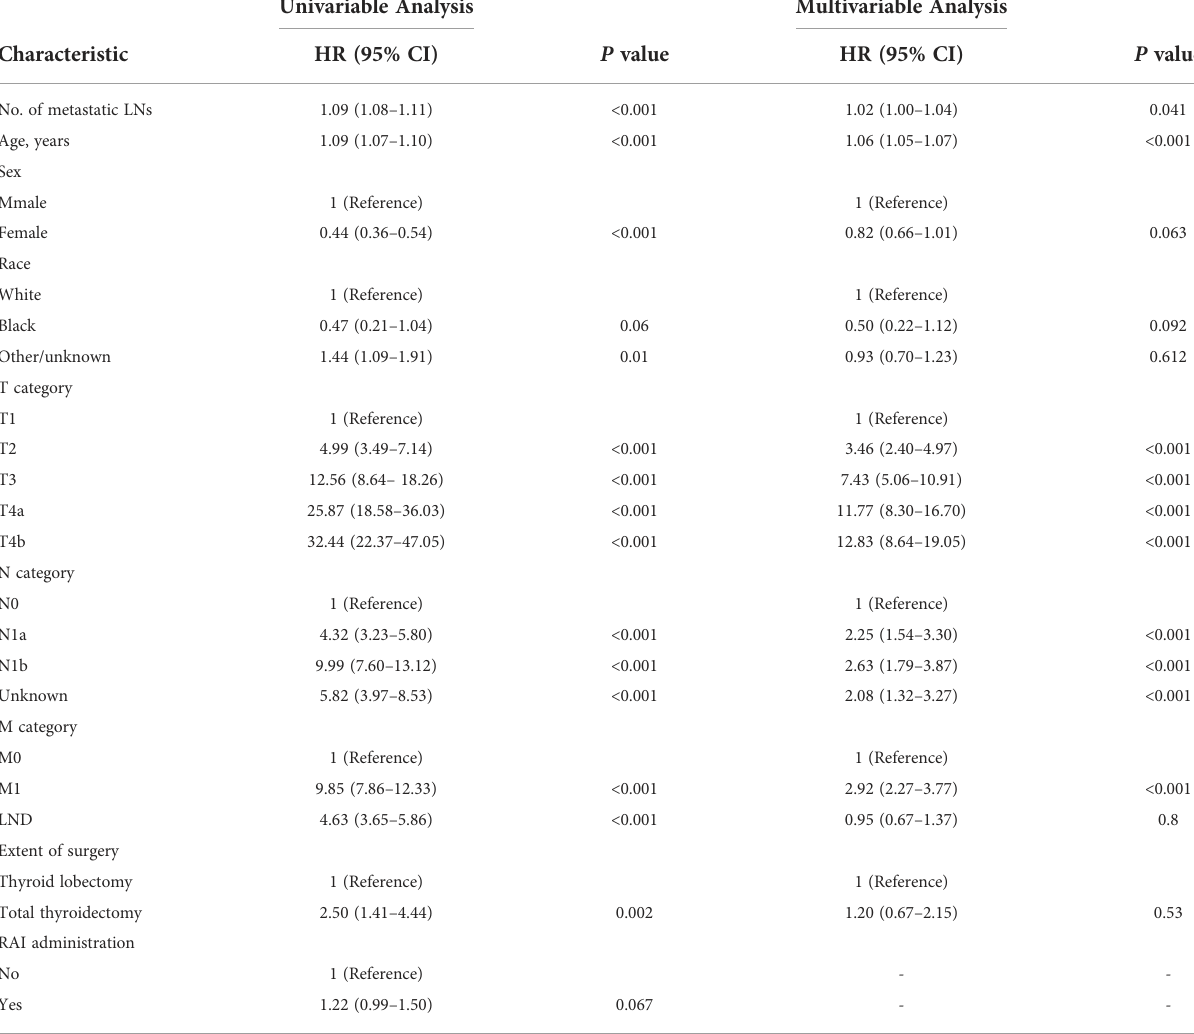
TABLE 2 Prognostic factors associated with cancer-speci fi c mortality. Univariable Analysis Multivariable